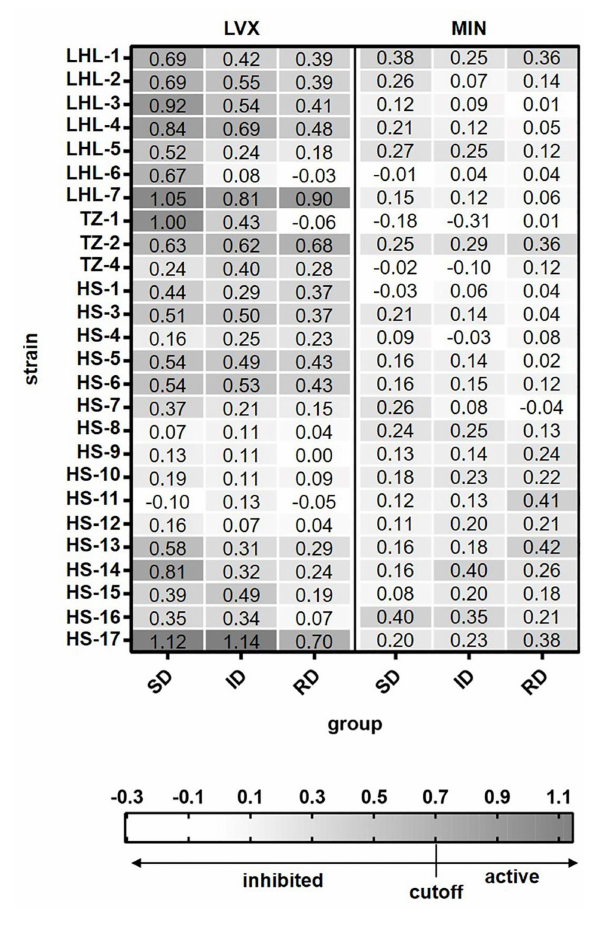
FIGURE 3 | The relative metabolic rate of 26 Elizabethkingia spp. strains determined by Raman-DIP. The antimicrobial concentrations of group SD, ID, and RD were obtained from the M100 guidelines (CLSI, 2019). SD, susceptible breakpoint corresponds to antimicrobial concentration; ID, intermediate breakpoint corresponds to antimicrobial concentration; RD, resistant breakpoint corresponds to antimicrobial concentration; MIN, minocycline; and LVX, levofloxacin. The relative metabolic rates of each concentration were shown in each